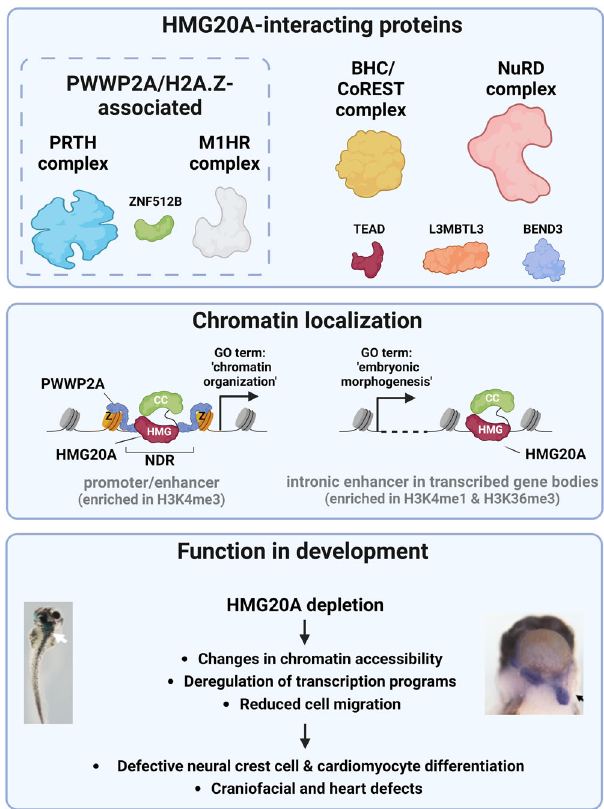
Fig. 9 | Model of HMG20A ’ s function in chromatin and transcriptional regula- tion during development. Top: HMG20A associates with H2A.Z- and PWWP2A- associated PRTH and M1HR complexes and ZNF512B as well as BHC/CoREST and NuRD complexes and TEAD and L3MBTL3 that are not part of H2A.Z or PWWP2A interactomes. Middle: HMG20A binds to two distinct chromatin regulatory ele- ments: (1) Nucleosome depleted regions (NDR) at promoter sites that are sur- rounded by H2A.Z-containing nucleosomes and bound by PWWP2A and that are associatedwithgenesinvolvedinbasicprocesses,suchas ‘ chromatinorganization ‘ . (2) H2A.Z-lacking intronic enhancers within transcribed genes belonging to developmental processes, such as ‘ embryonic morphology ” . Bottom: Depletion of HMG20A in Xenopus laevis and mESCs leads to changes in chromatin accessibility, deregulation of transcription programs as well as migration defects. HMG20A depletedcellsfailtoproperlydifferentiateintoneuralcrestcellsorcardiomyocytes in mESCs as well as head and heart in Xenopus laevis . Figure was created with